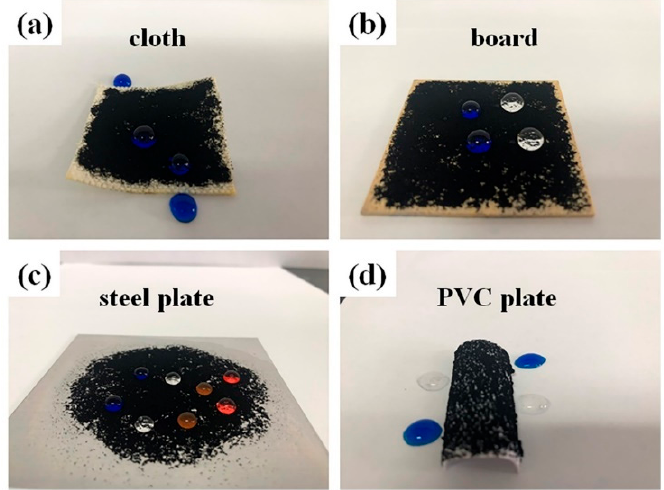
Figure 2. The superhydrophobic composite coatings coated on cloth ( a ), board ( b ), steel plate ( c ), and PVC plate ( d ). Water drops were dyed blue by methylene blue, dyed orange by coffee, and dyed red by methyl orange in acids.